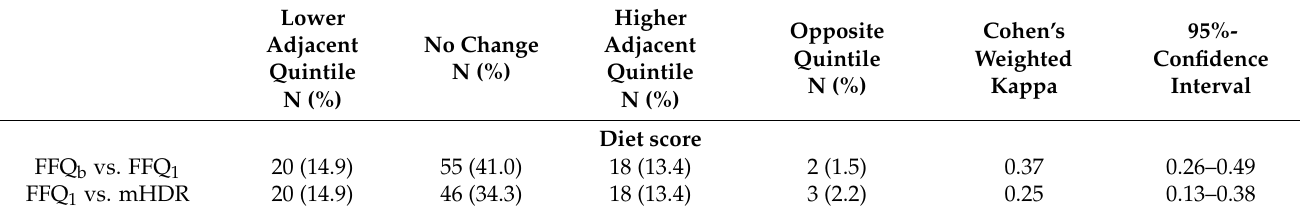
Table 5. Agreement to the quintiles for the new diet